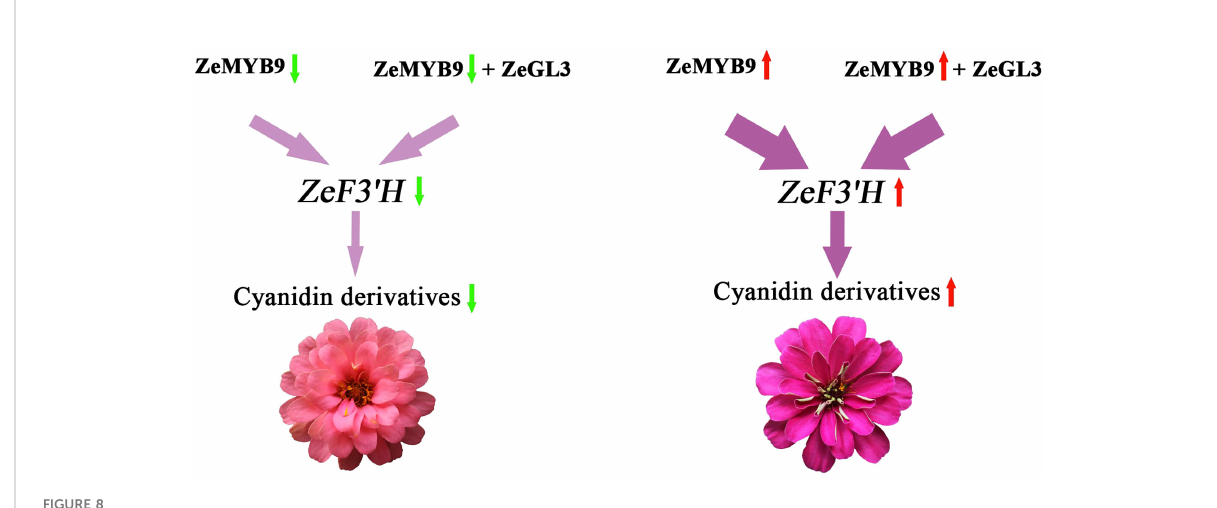
FIGURE 8 Diagram of regulatory pattern of ZeMYB9 in Z. elagans